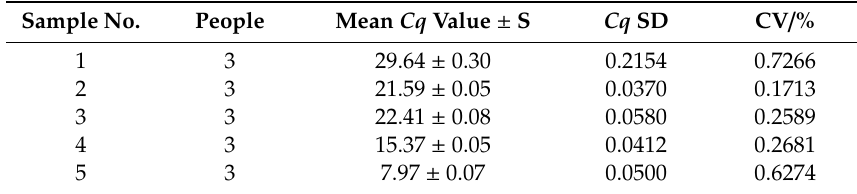
Table 3. The coe ffi cient of variation (CV) analysis of PTP2-qPCR. Table 3. The coefficient of variation (CV) analysis of PTP2-qPCR . Sample No.